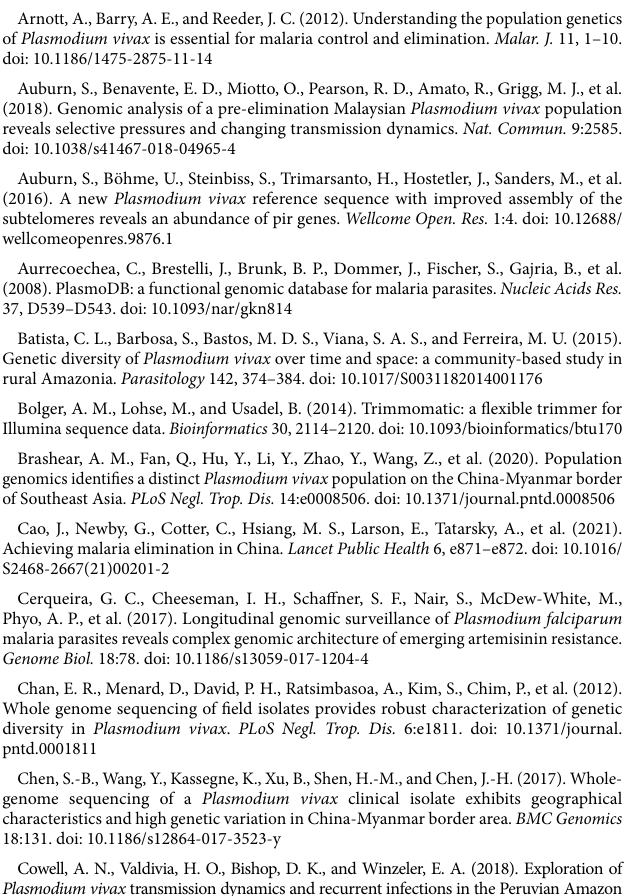
SUPPLEMENTARY FIGURE S1 PCA plots illustrating the parasite population structure in China inland samples relative to reference mapped with the P01 genome. The China* samples are also downloaded from Pearson et al.’s study, which was collected from Yunnan, China in 2011.